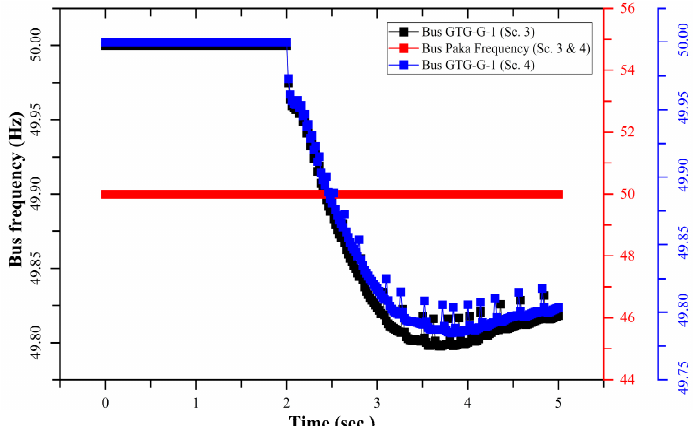
Figure 8. Bus frequency of the test system for under frequency (Scenario 3 and Scenario 4).